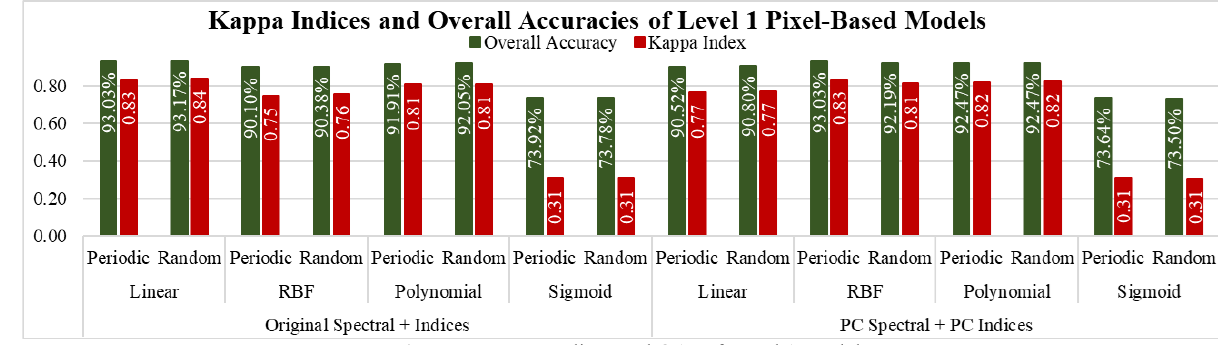
Figure 7. Kappa Indices and OAs of Level 1